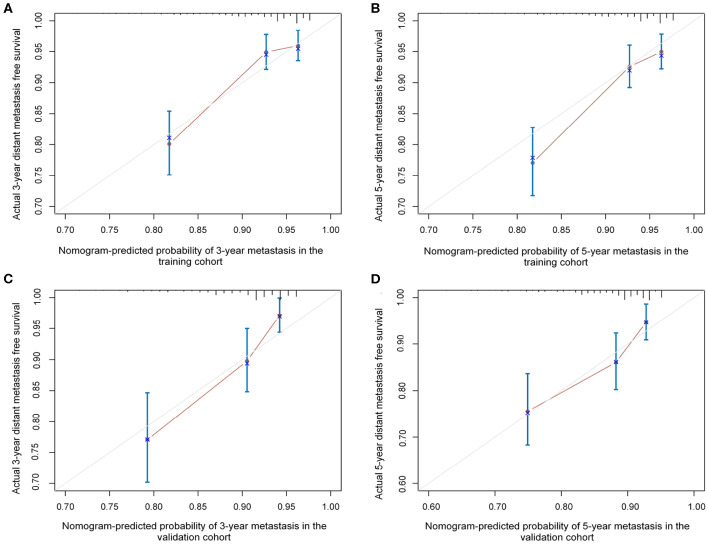
The calibration plots of the established nomogram in predicting the 3- and 5-year distant metastasis-free survival in the training cohort (A,B) and validation cohort (C,D).